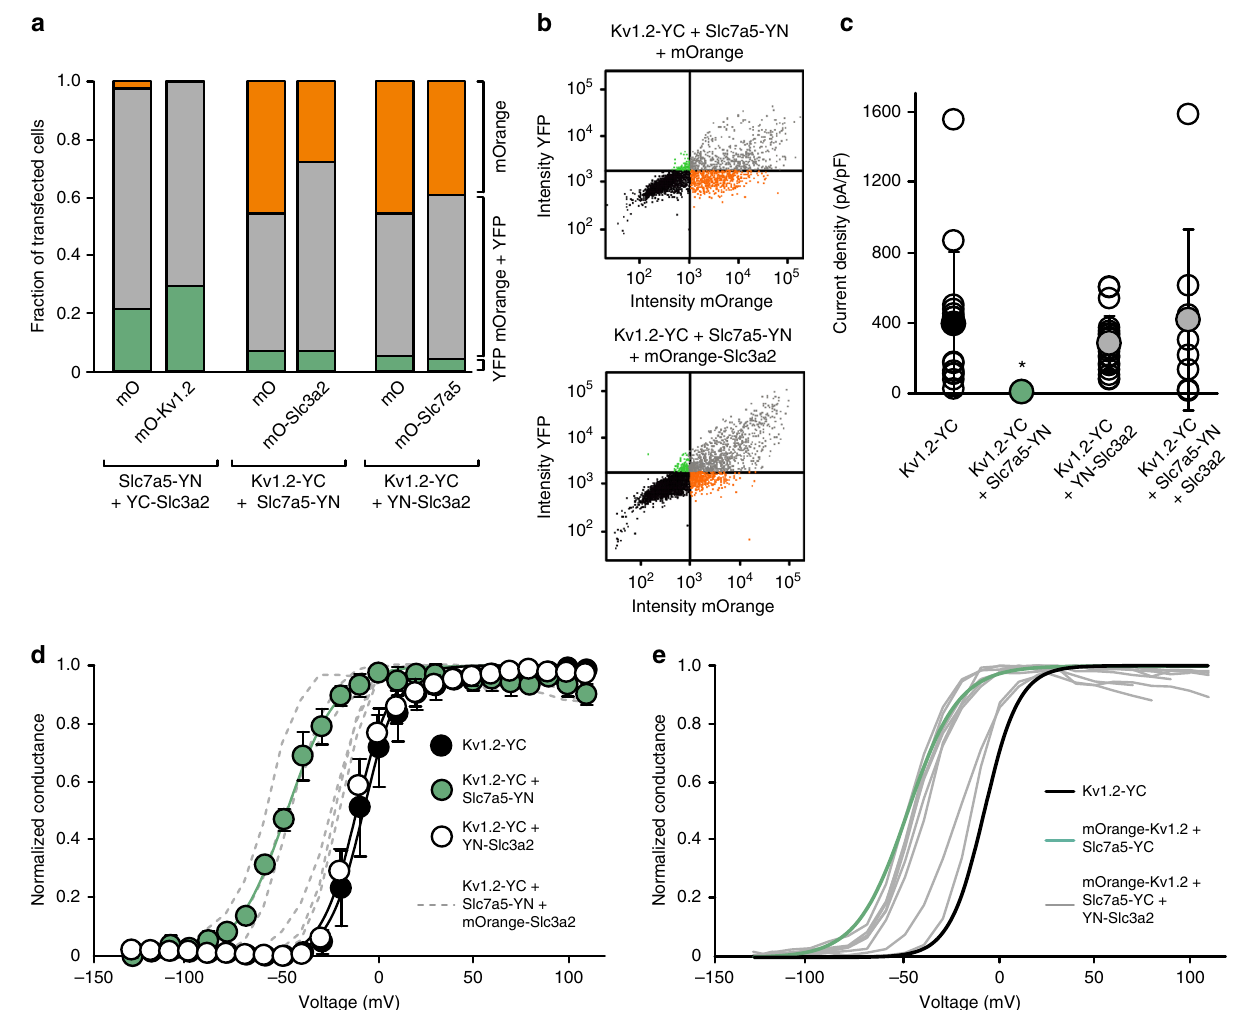
Fig. 7 Using split YFP constructs to measure competition for Slc7a5 between Kv1.2 and Slc3a2. YFP fragments (YFPN residues 1 – 157, YN; and YFPC residues 158 – 239, YC) were fused to Kv1.2, Slc3a2, and Slc7a5 as indicated. a Fluorescence-activated cell sorting was performed on split-YFP tagged versions of Kv1.2, Slc7a5, and Slc3a2, with the third protein tagged with LSS-mOrange. All DNA transfections were done at a 1:1:1 ratio. Bars represent the distribution of transfected cells with prominent mOrange fl uorescence (upper left quadrant in b ), prominent YFP (lower right quadrant), or prominent signals from both fl uorophores (upper right quadrant). b Representative data from FACS sorting of cells in the Kv1.2-YFPC + Slc7a5-YFPN + mOrange or + mOrange-Slc3a2 conditions. c Kv1.2-YFPC was expressed with combinations of Slc7a5-YFPN and Slc3a2 as indicated. The data from individual cells are plotted along with the mean ± s.d., n = 7 – 20. d Conductance-voltage relationships were generated for each condition after current disinhibition with a 30 s hyperpolarization to − 120 mV (Kv1.2-YFPC V 1/2 = − 8.4 ± 7, n = 10; Kv1.2-YFPC + Slc7a5-YFPN V 1/2 = − 49 ± 2, n = 5; Kv1.2-YFPC + YFPN-Slc3a2 V 1/2 = − 11 ± 4, n = 11). Individual conductance-voltage relationships for six cells transfected with Kv1.2-YFPC + Slc7a5-YFPN + Slc3a2 are depicted in gray (overall V 1/2 = − 36 ± 16 mV). Data at each voltage are presented as mean ± s.d., n = 4 – 11. e Individual conductance-voltage relationships for seven cells transfected with mOrange-Kv1.2 + Slc7a5-YFPC + YFPN-Slc3a2 (transfection ratio